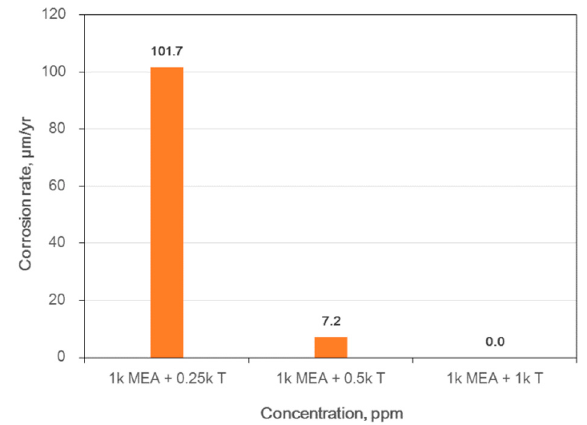
Figure 6. Effect of co-addition of corrosion inhibitors on the corrosion rate of DCI in [tap water + 1 k ppm monoethanolamine (MEA) + x ppm tungstate (T)] at room temperature.